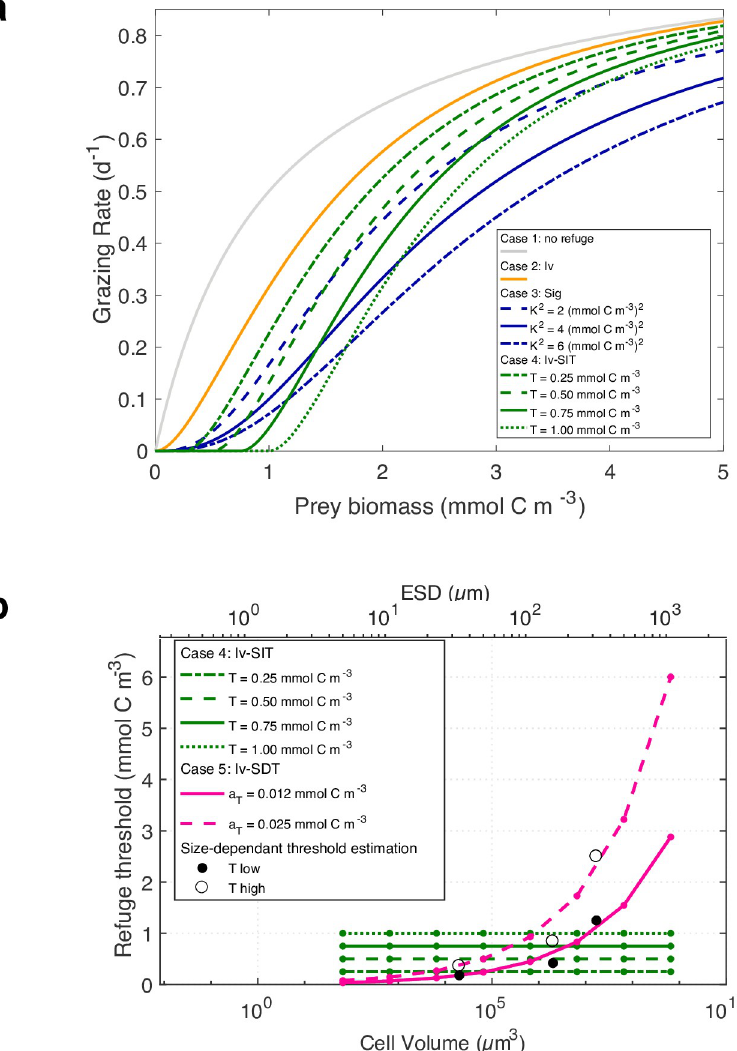
Fig 2. (a) Grazing effort as a function of prey biomass for cases 1–4 from Table 1. Solid lines correspond to cases presented in the core paper (other cases are presented in supporting information). (b) Specification of an explicit refuge food concentration T where grazing is initiated for case 4 (size-independent threshold, green lines with four different parameter values) and case 5 (body size-dependent threshold T as a function of zooplankton biovolume and ESD, pink lines). Black and white dots correspond to low and high estimates from the literature, respectively; pink lines represent T fitted to these estimates with an allometric relationship T = a T V b , with a T -low = 0.012 mmol C m -3 , a T -high 0.025 mmol C m -3 , and b = 0.27 (cases 5, Iv-SDT). Green lines represent size-independent T (cases 4,